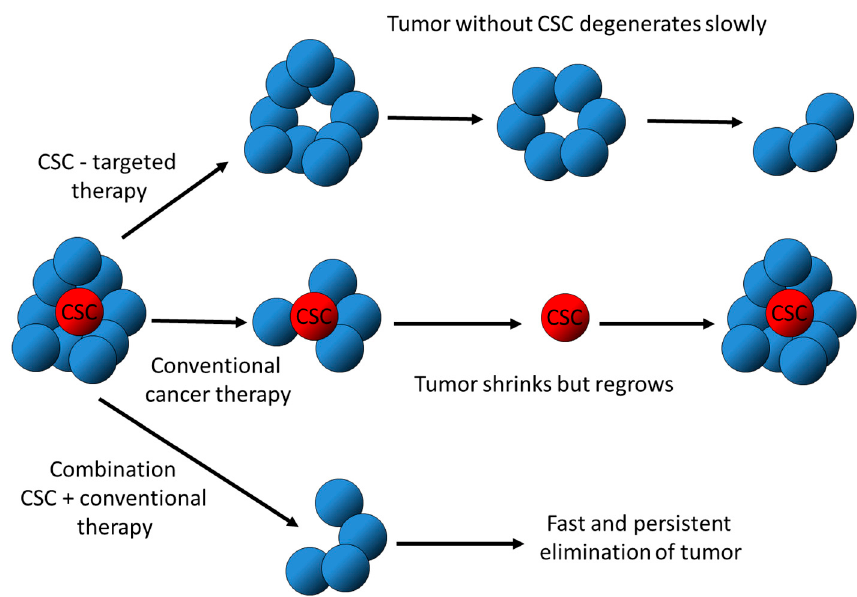
Figure 1. Natural products targeting CSC to augment conventional cancer therapeutics.